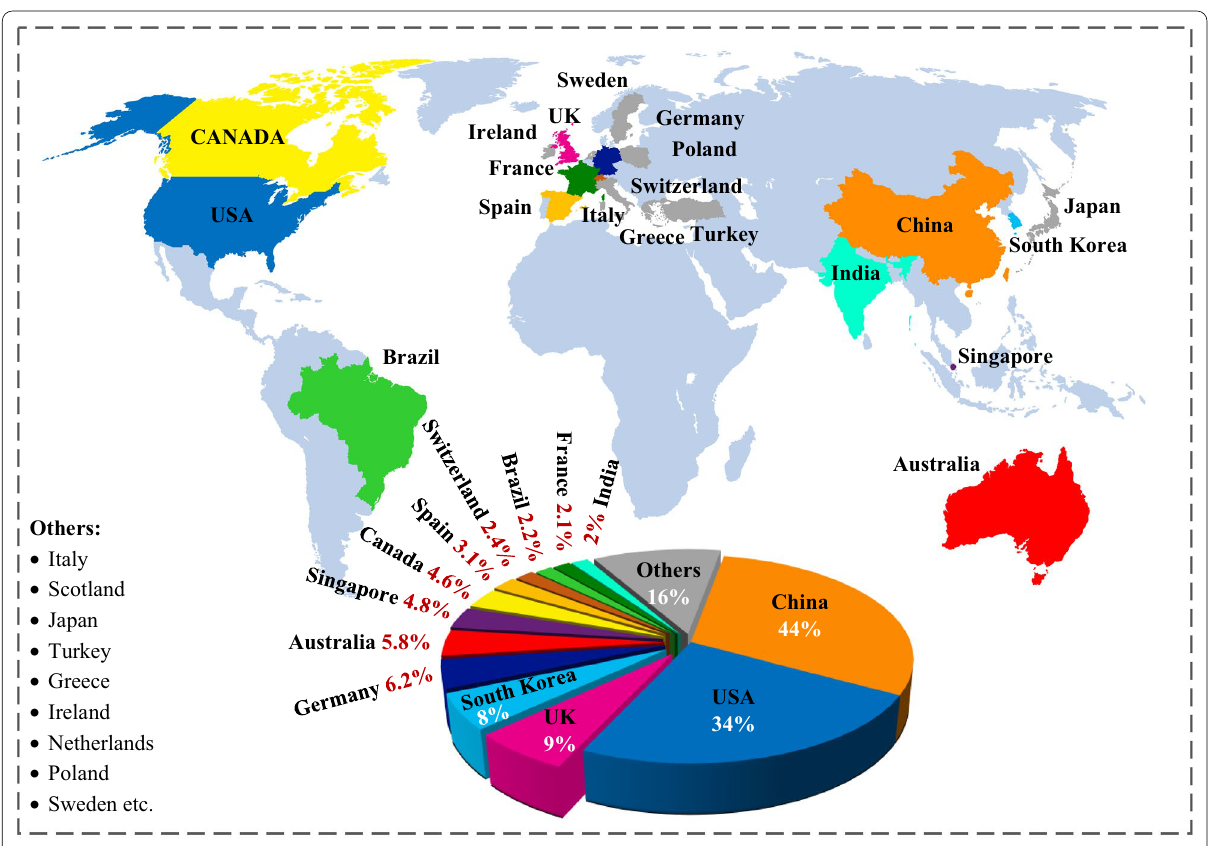
Fig. 1 Contribution of the most prolific countries in the flourishment of 3D-printed mechanical energy harvesting